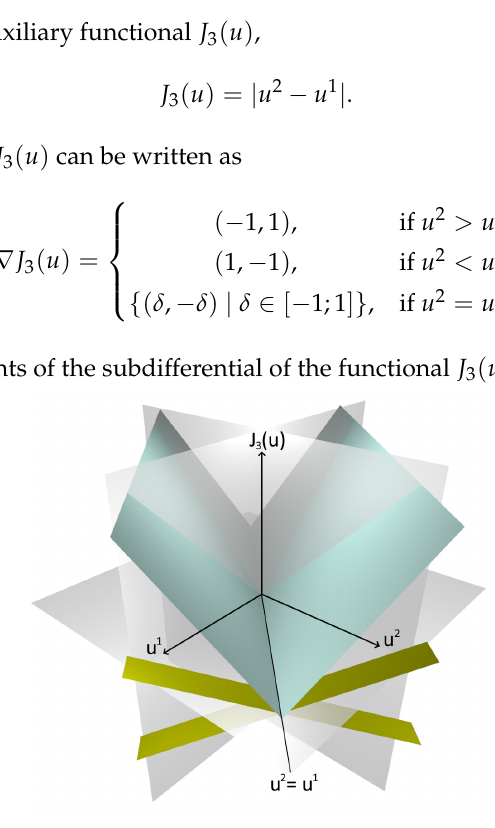
Figure 1. Coordinate planes (gray color), graph of the functional J 3 ( u ) (green color), planes corresponding to elements of subdifferential of the functional J 3 ( u ) when u 2 = u 1 (yellow